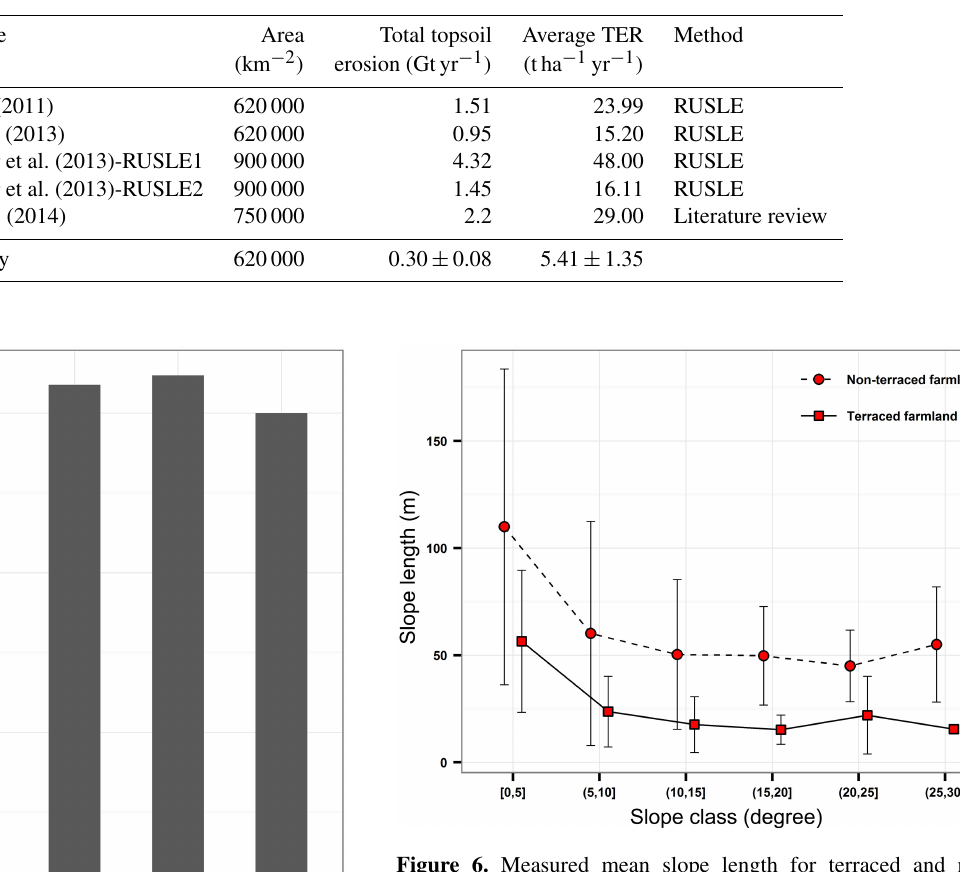
Figure 6. Measured mean slope length for terraced and non- terraced farmland in different slope classes on the CLP (GEps ob- servations). Field sizes and hence slope length are clearly larger on gentle